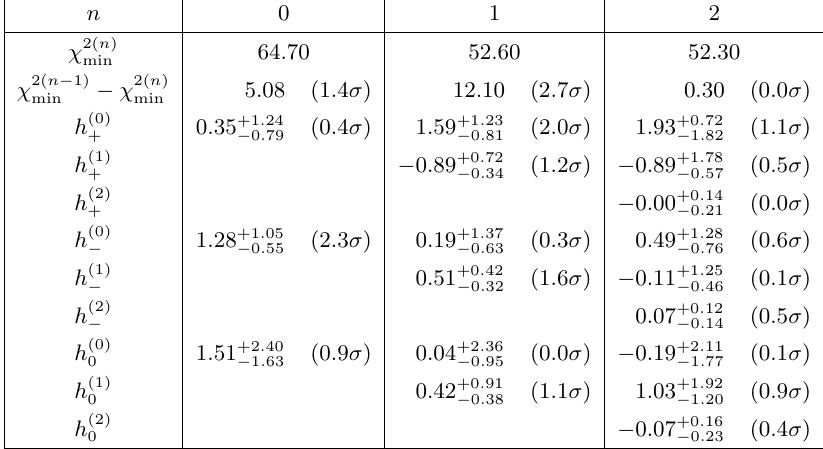
the e(cid:11)ect of charm loops in B ! K‘ + ‘ (cid:0) (in agreement with ref. [17]). Compared to ref. [12]